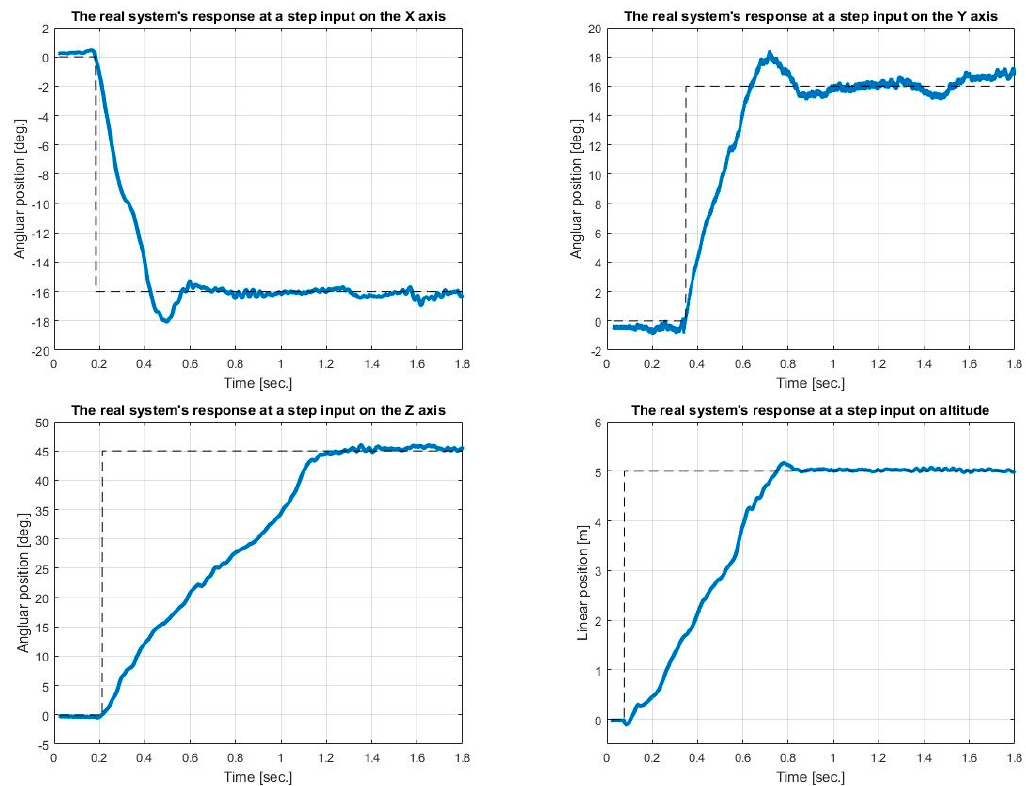
Figure 12. The closed loop system output for step input on each axis.